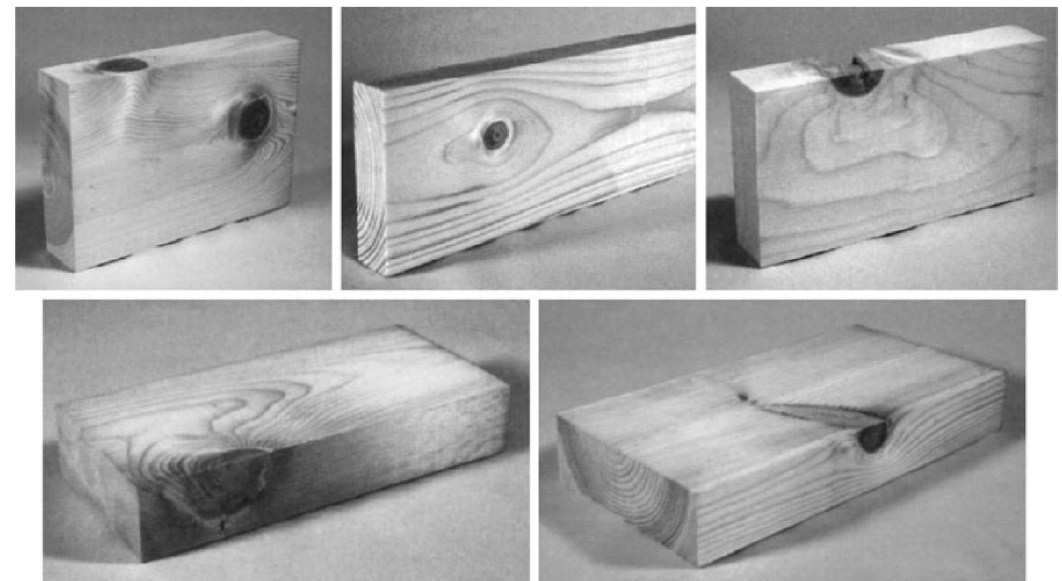
Figure 54. Main types of knots according to their position on the piece. Listing from left to right and top to bottom: edge and face knots, inner through knot, outer through knot, arris knot, splay knot. From [175].